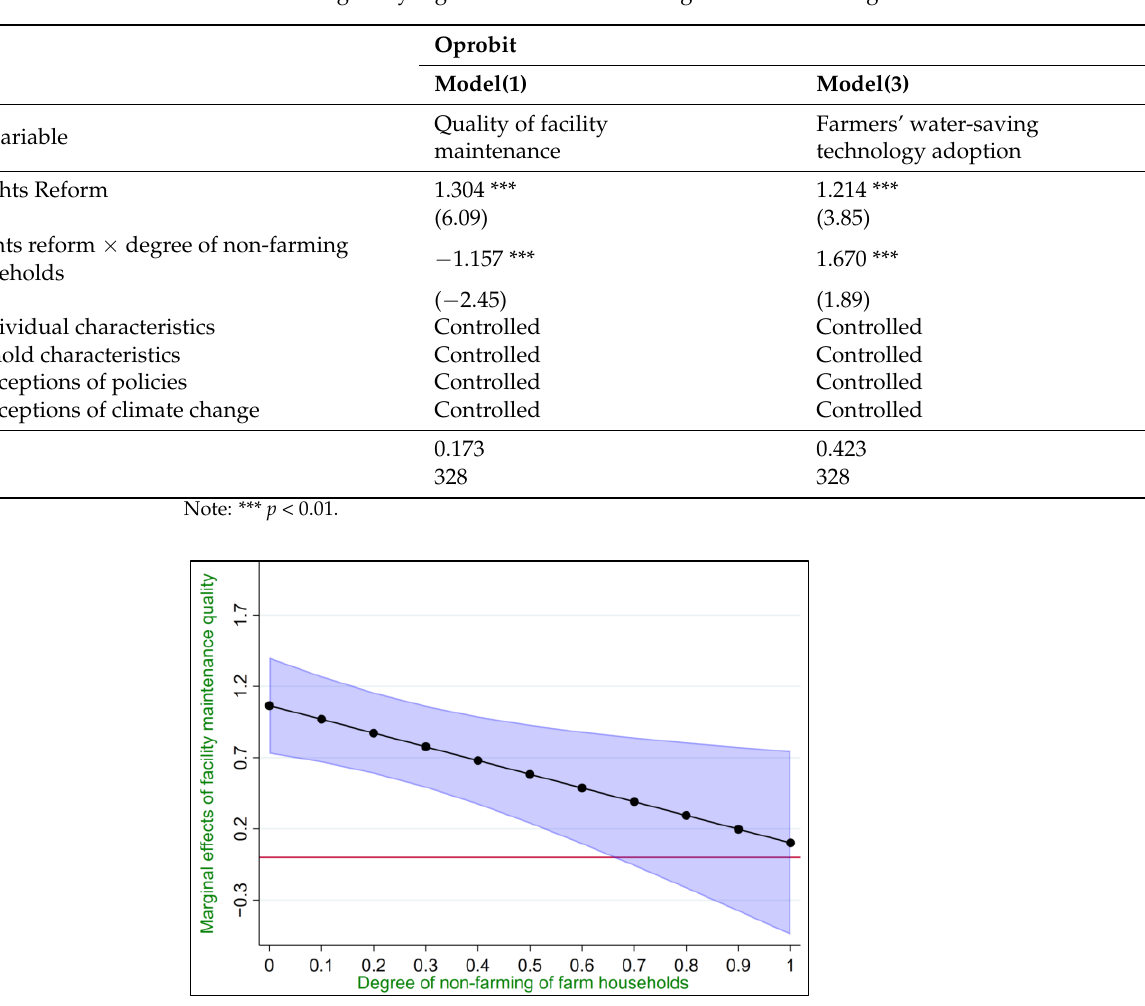
Figure 6. Moderating effect of the degree of non-farming of farm households on the adoption behavior of water-saving technologies. (Note: The black dashed line in the figure represents the moderating effect of the degree of farm household de-farming on the adoption behavior of farmers ’